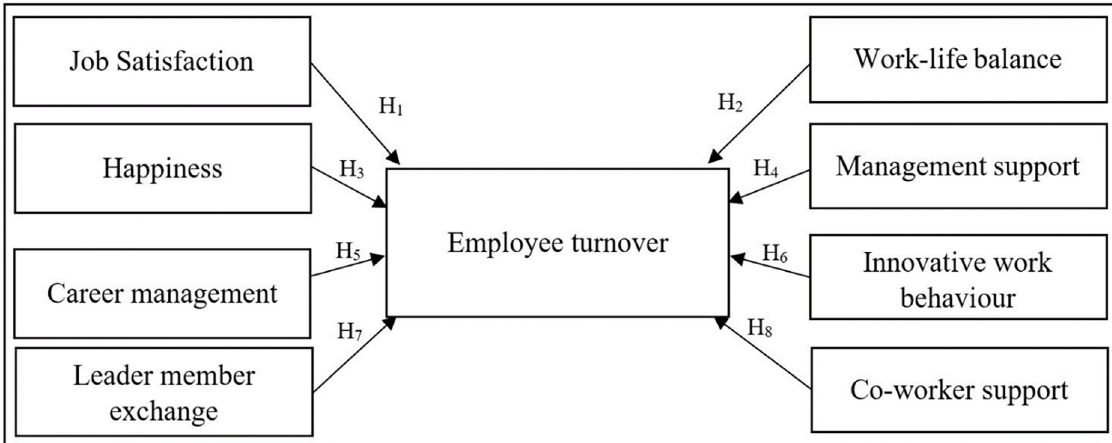
Fig 2. Conceptual framework. Source: Authors’